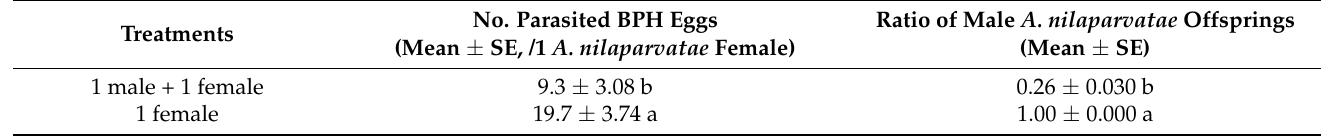
Table 1. Comparison of parasitism ability of female A. nilaparvatae with/without male participation. Treatments